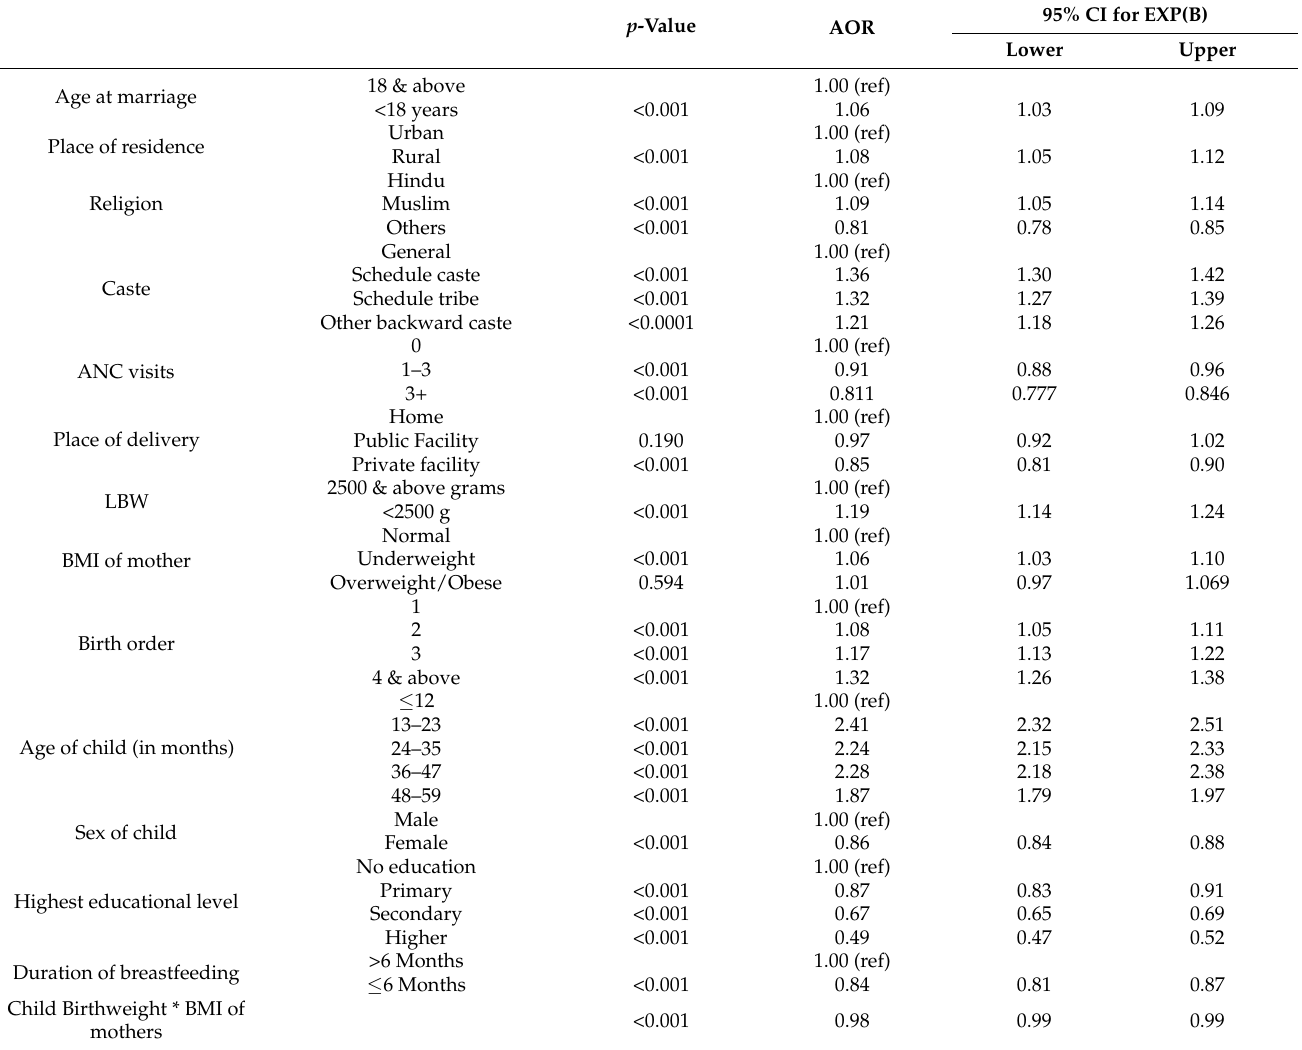
compared to normal birth weight babies. The other observed associations in the bivariate table between the age of children, education of reproductive women, a social hierarchy based on caste and religion with stunting of children were supported by multivariable results of Table 2. For instance, women with more than secondary education compared to no education experienced 51% lower odds of having stunted children (AOR = 0.49; CI 0.47, 0.52; p < 0.001). Similarly, women who belong to Scheduled Caste compared to General Caste had 36% higher odds of having stunted children (AOR = 1.36; CI 1.30, 1.42; p < 0.001); and children aged 13–23 months compared to children up to one-year-old had 141% higher odds of being stunted (AOR = 2.41; CI 2.32, 2.51; p < 0.001). Regarding religion, Muslims had 9% higher odds of having stunted children compared to Hindus (AOR = 1.09; CI 1.05, Table 2. Adjusted odds ratios (AORs) for the association of covariates with stunting of children in India. 95% CI for EXP(B) p -Value AOR Lower Upper